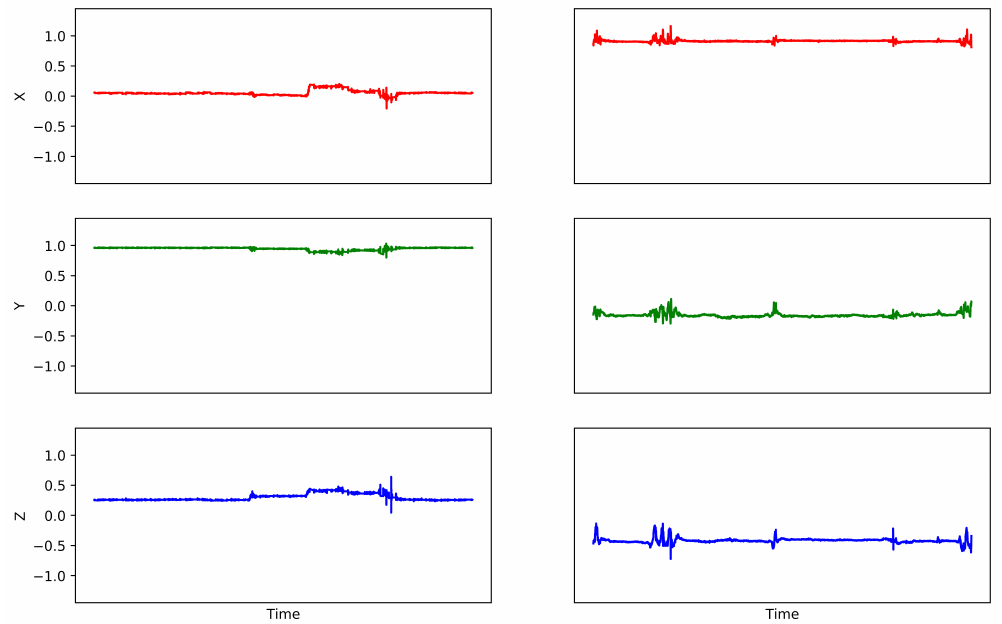
Figure 2. Accelerometer data sequences for two different patients (early and middle stage,